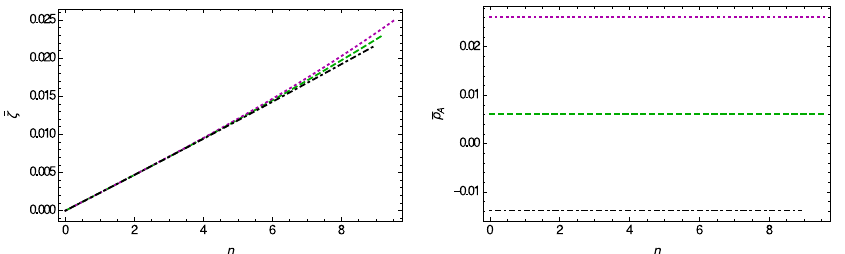
Fig. 9 Variation of ¯ ζ (left panel) and ¯ ρ A (right panel) as a function of η in three-form field photon stars, for three different values of the con- stant ¯ λ : ¯ λ = 0 (dashed curve), ¯ λ = 0 . 02 (dotted curve), and ¯ λ = − 0 . 02